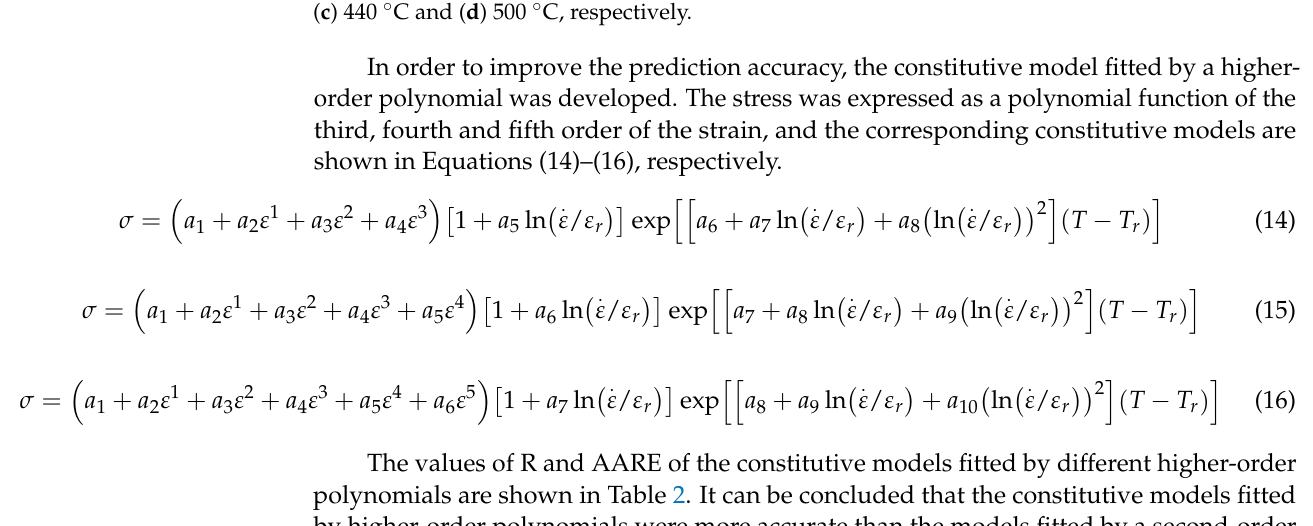
Figure 6. Comparison between the predictive value of the constitutive model fitted by a power- exponential function and the experimental stress-strain curves at temperature of ( a ) 320 °C, ( b ) 380 °C, ( c ) 440 °C and ( d ) 500 °C, respectively.